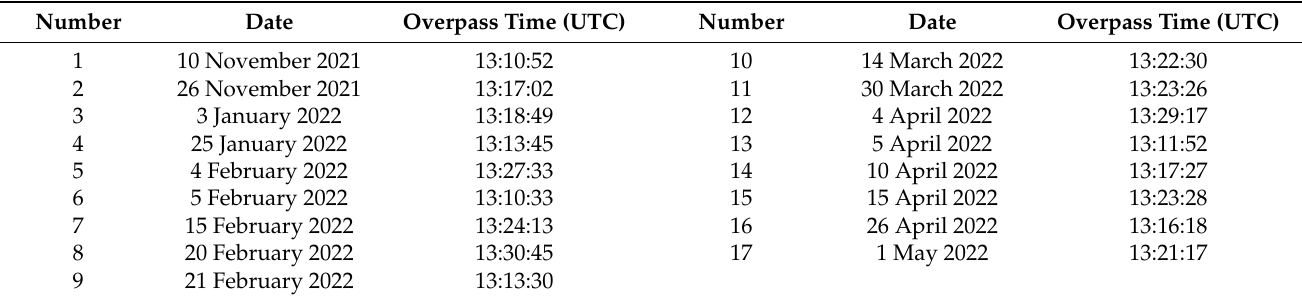
Figure 1. The location of the study area (Beijing) and the night light image of it acquired by SDGSAT-1. The surface of Beijing can be characterized by the SDGSAT-1 daytime true-color composite image on 5 March 2022 ( a ) and the nighttime true-color composite image on 15 April 2022 ( b ). We selected five Aeronet stations over the study area: site 1 is Beijing_RADI station, site 2 is Beijing station, site 3 is Beijing_PKU station, site 4 is Beijing_CAMS station, and site 5 is Xianghe station. Table 1. The selected L4A images of SDGSAT-1/GLI in